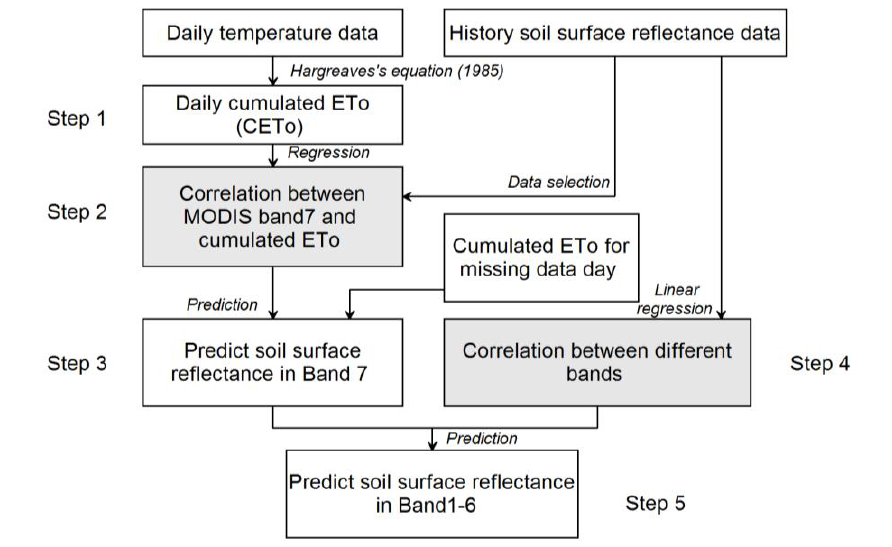
Figure 4. Data-processing